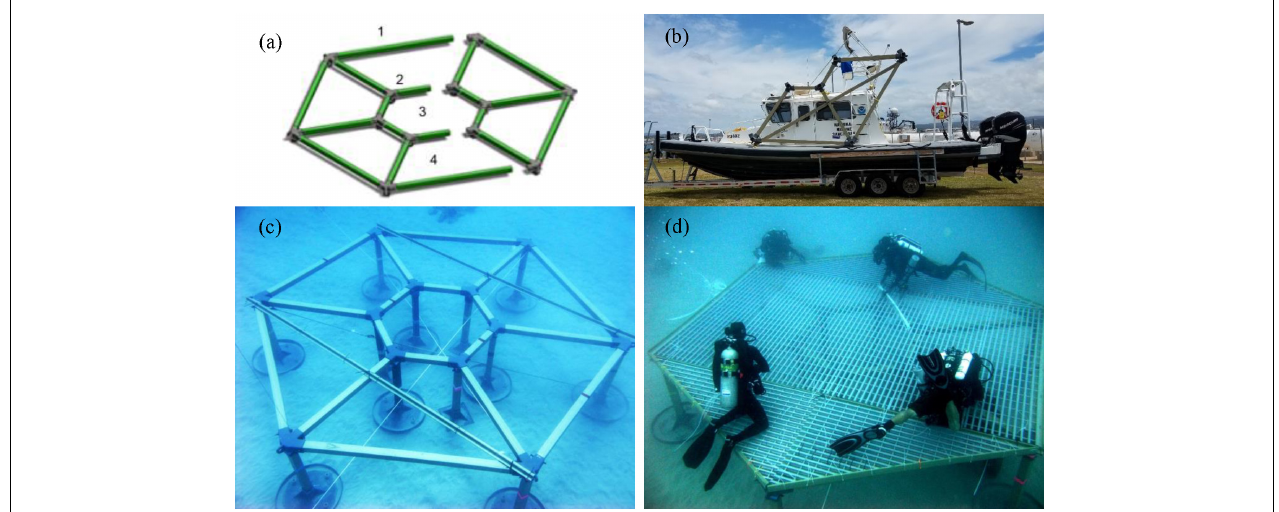
FIGURE 5 | (a) The pre-assembled halves, and installation method under water, (b) NOAA 36 ft vessel R/V Hihimanu of the Papahanaumokuakea National Marine Monument with pre-constructed nursery top surface secured to side, and (c,d) the deployed coral nursery structure